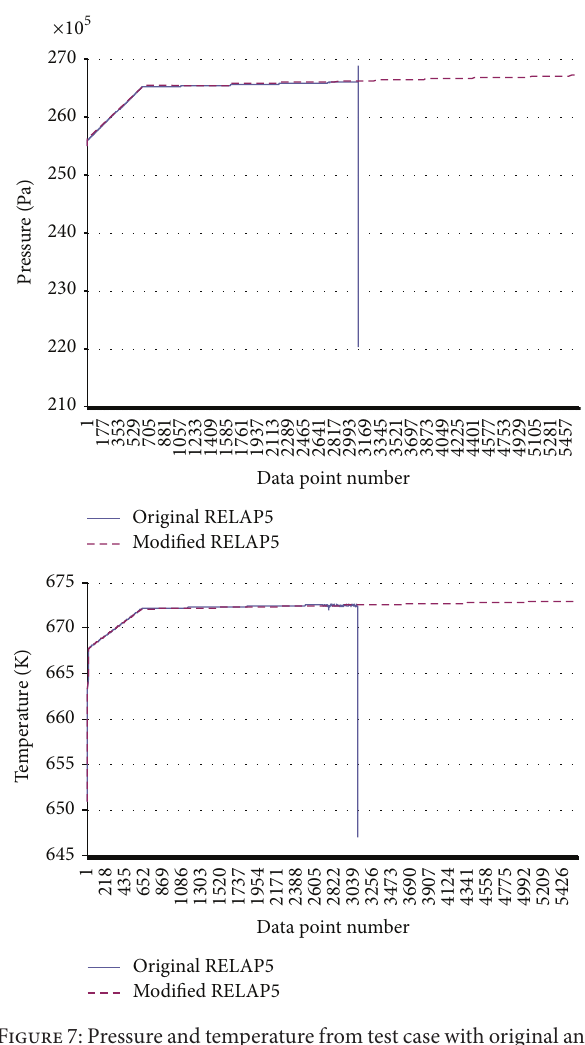
Figure 7: Pressure and temperature from test case with original and modified